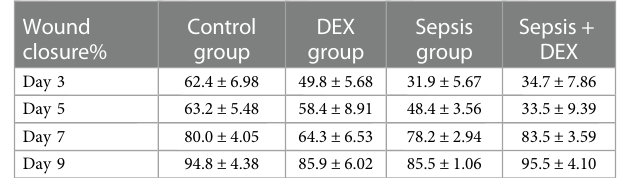
TABLE 3 The data of wound